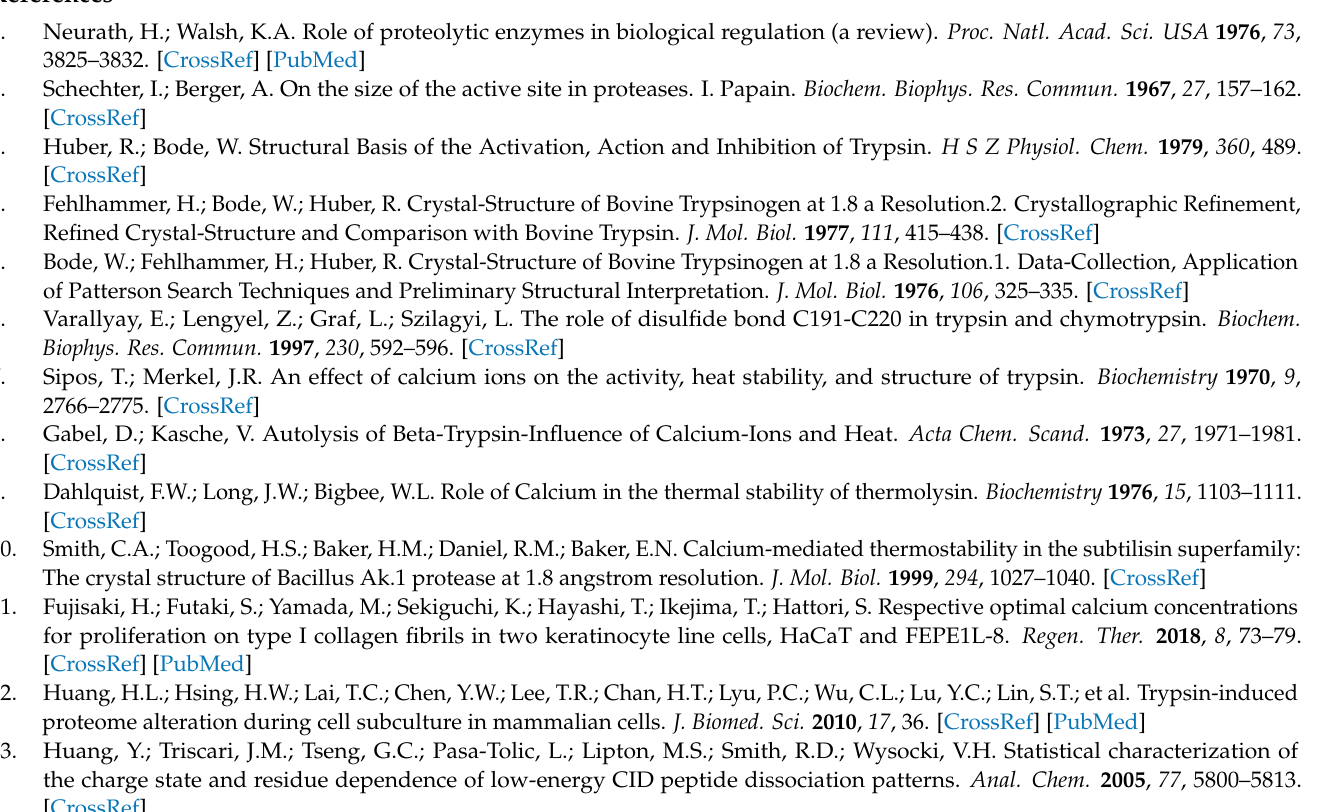
Figure S2: Calibration curve and results for the determination of free thiols, Figure S3: Non-reducing SDS-PAGE of the Tn variants, Figure S4: Hydrolysis of Bz-Arg-AMC, Figure S5: v/[S]-regression curves of Bz-Arg-AMC conversion catalyzed by diverse trypsin variants, Figure S6: Alignment of the protein sequences of anionic rat trypsin II and cationic bovine trypsin, Figure S7: Circular dichroism (CD) measurements of bovine trypsin species, Figure S8: Thermal denaturation of aTn(bov) S195A and wt-Tn(bov) S195A measured by CD-spectroscopy, Figure S9: Overall structure of aTn(bov) S195A, Figure S10: Ca 2+ -binding site of trypsin, Figure S11: SDS-PAGE and mass spectrometry of trypsin variants, Table S1: Sequences of the primers used for site-directed mutagenesis, Table S2: Overview of the crystallization data and refinement statistics of aTn(bov) S195A